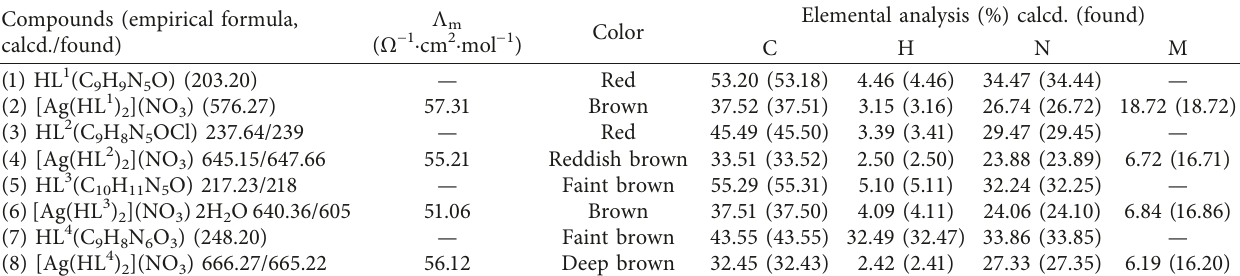
Table 1: Analytical and physical data for Ag(I)-pyrazolone (HL 1–4 ) complexes. Compounds (empirical formula,